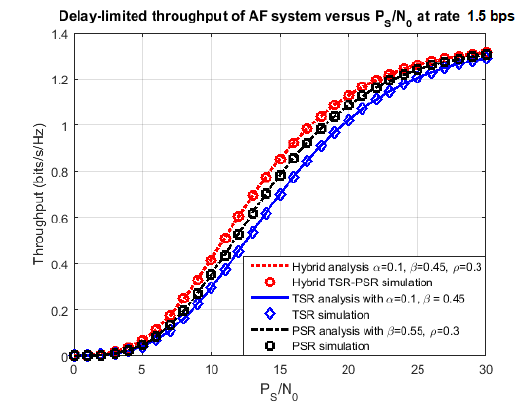
Fig. 4: Throughput versus P S /N 0 for 3 protocols.